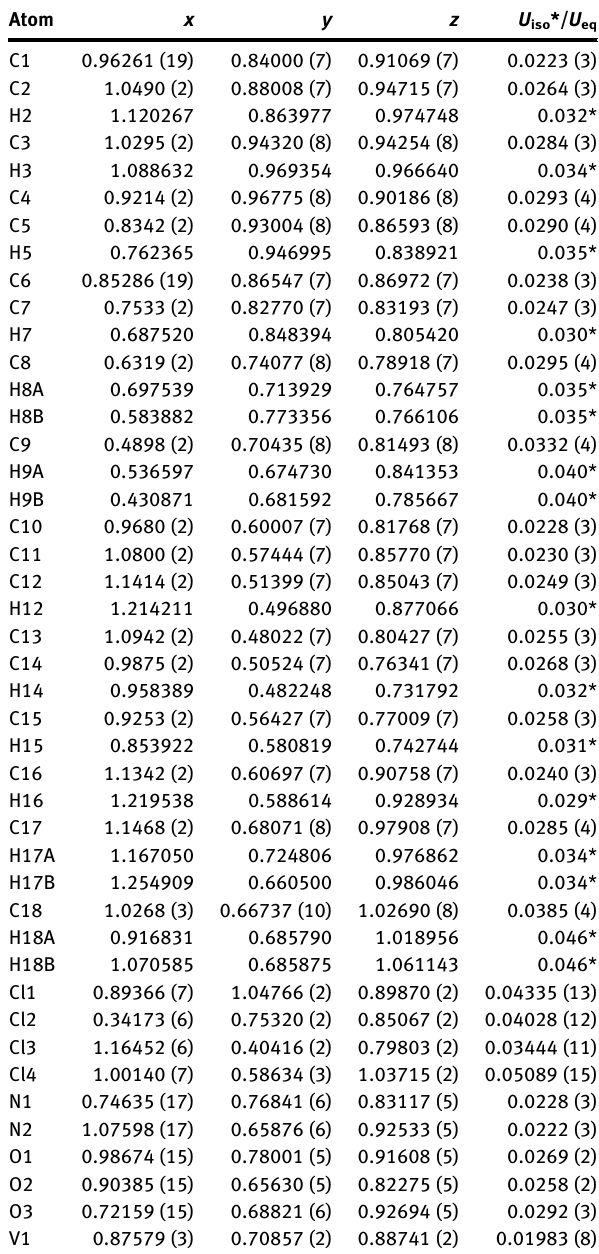
Table  : Fractional atomic coordinates and isotropic or equivalent isotropic displacement parameters (Å 